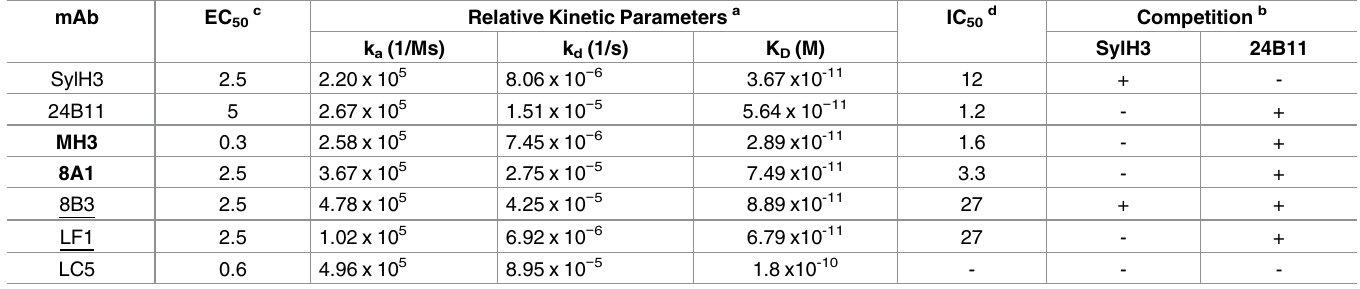
Table 1. Properties of new anti-RTB mAbs compared to 24B11and SylH3.